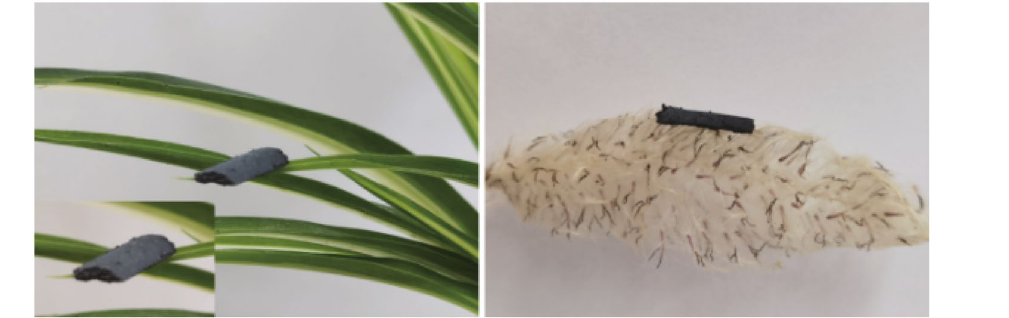
Fig. 4 Images of LDHT composite on a leaf and b reed flocculants